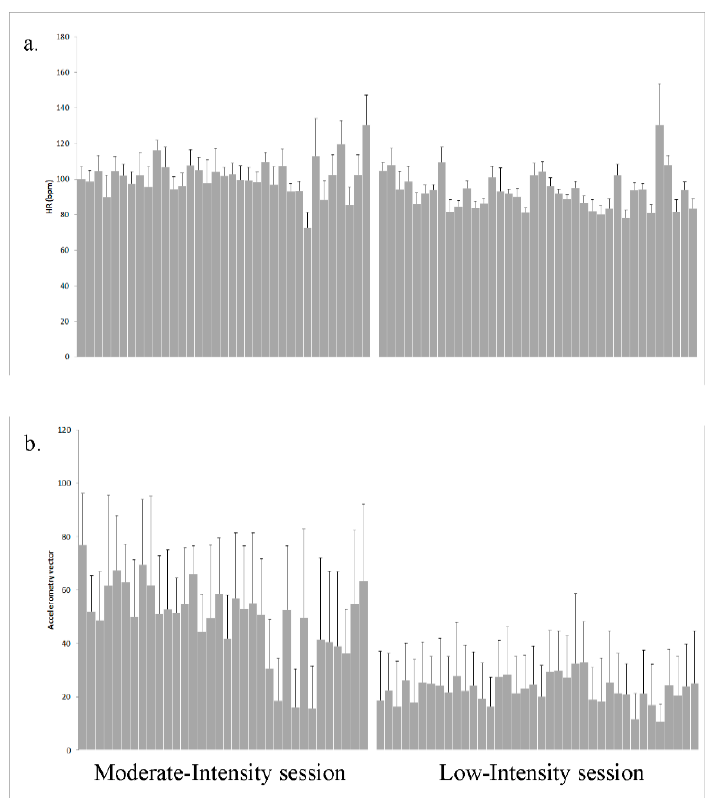
Figure 1. ( a ) Mean and standard deviation of the heart rate at each session for each of the subjects participating in the sessions. ( b ) Mean and standard deviation of the magnitude of the triaxial vector of the accelerometer of each session for each of the subjects participating in the sessions.